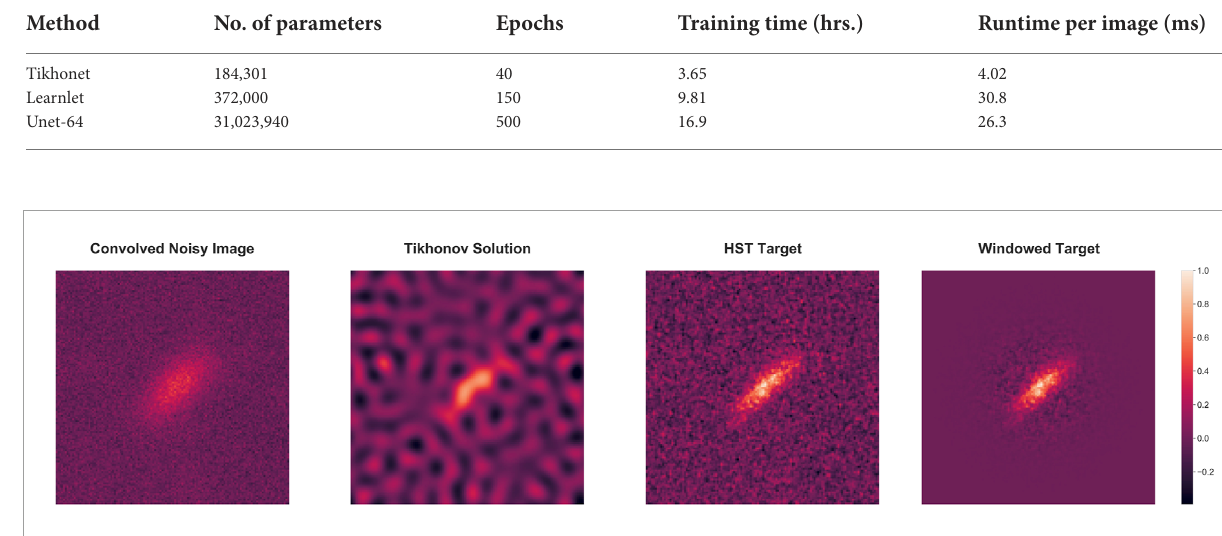
FIGURE 3 An example of Tikhonov output (second image) along with the weighted Target image using a Gaussian window (fourth